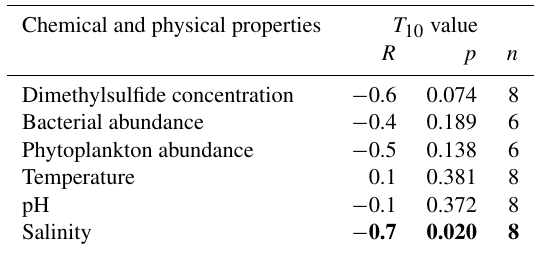
Table 2. Correlation analyses between chemical or physical proper- ties of bulk seawater and T 10 values for the bulk seawater samples. Numbers in bold represent correlations that are statistically signifi- cant ( p < 0 .